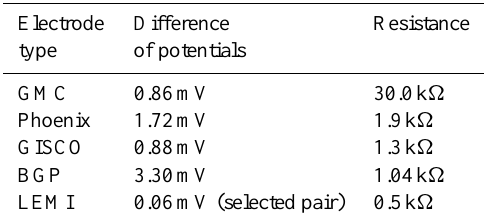
Table 1. Mean parameters of the electrodes immersed in wet